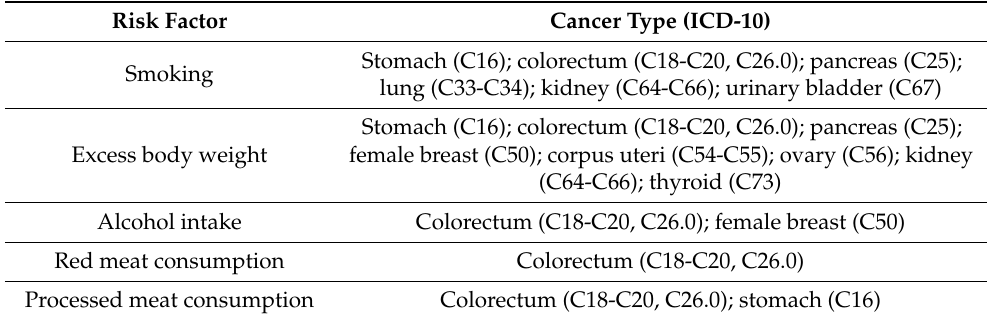
Table 1. Factors associated with increased cancer risk (by cancer type, ICD-10) used in this study. Risk